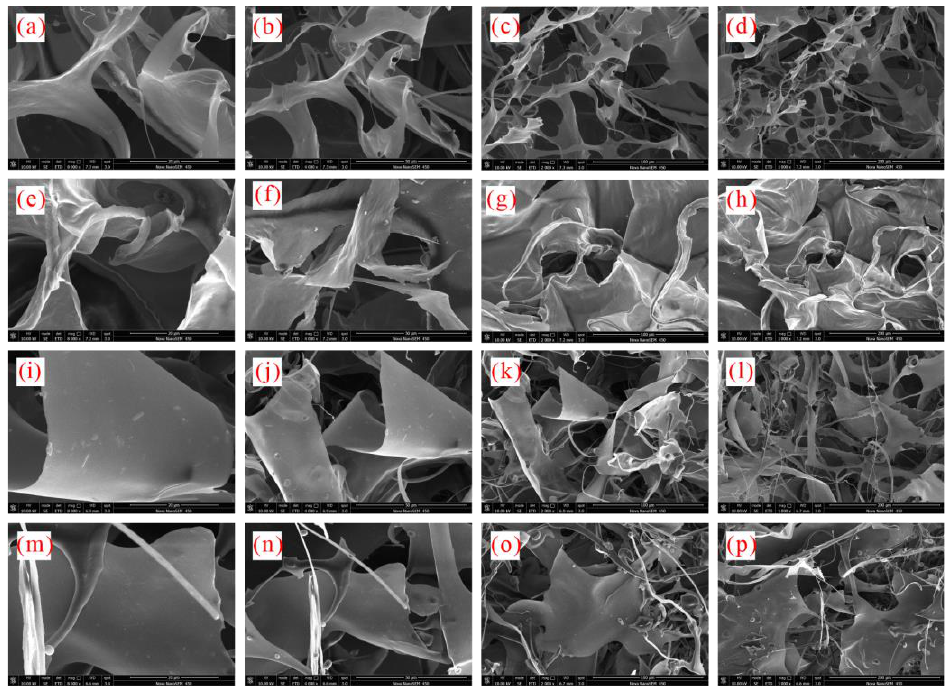
Figure 8. Meso-structures of lyophilized samples of xanthan gum and pectin aqueous solutions: ( a – d ) 0.1 wt% xanthan gum; ( e – h ) 0.5 wt% xanthan gum; ( i – l ) 0.1 wt% pectin; ( m – p ) 0.5 wt% pectin.